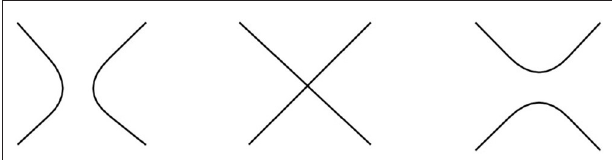
FIGURE 10 | Hyperbolic singularity curve bifurcation of Equation (26).